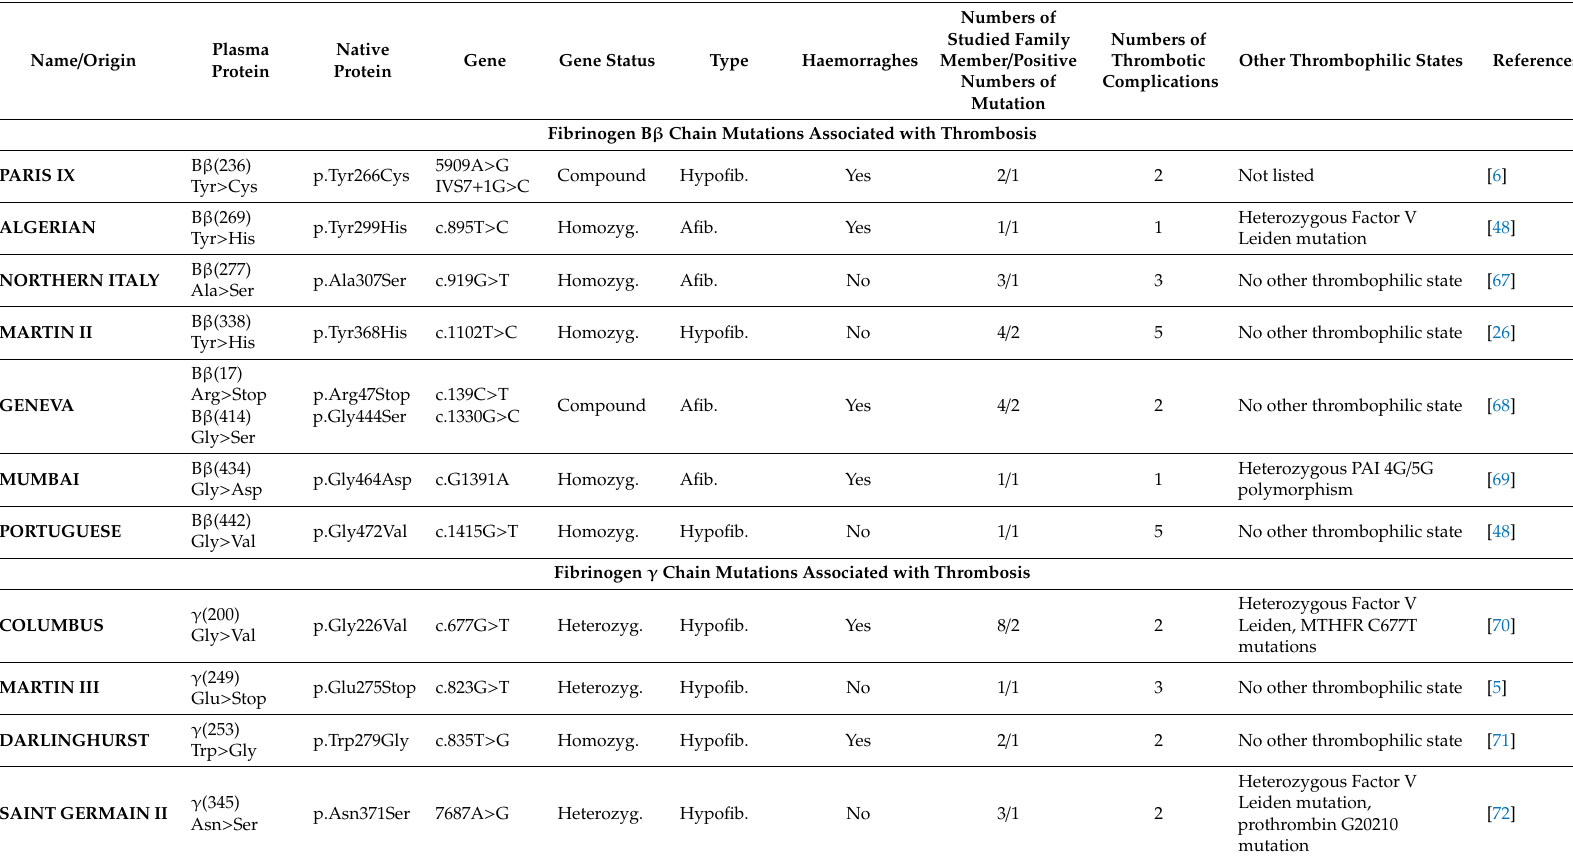
Table 2. Description of clinical studies and mutations in exons of FGB and FGG genes encoding beta and gamma nodules of fibrinogen molecule associated with thrombotic